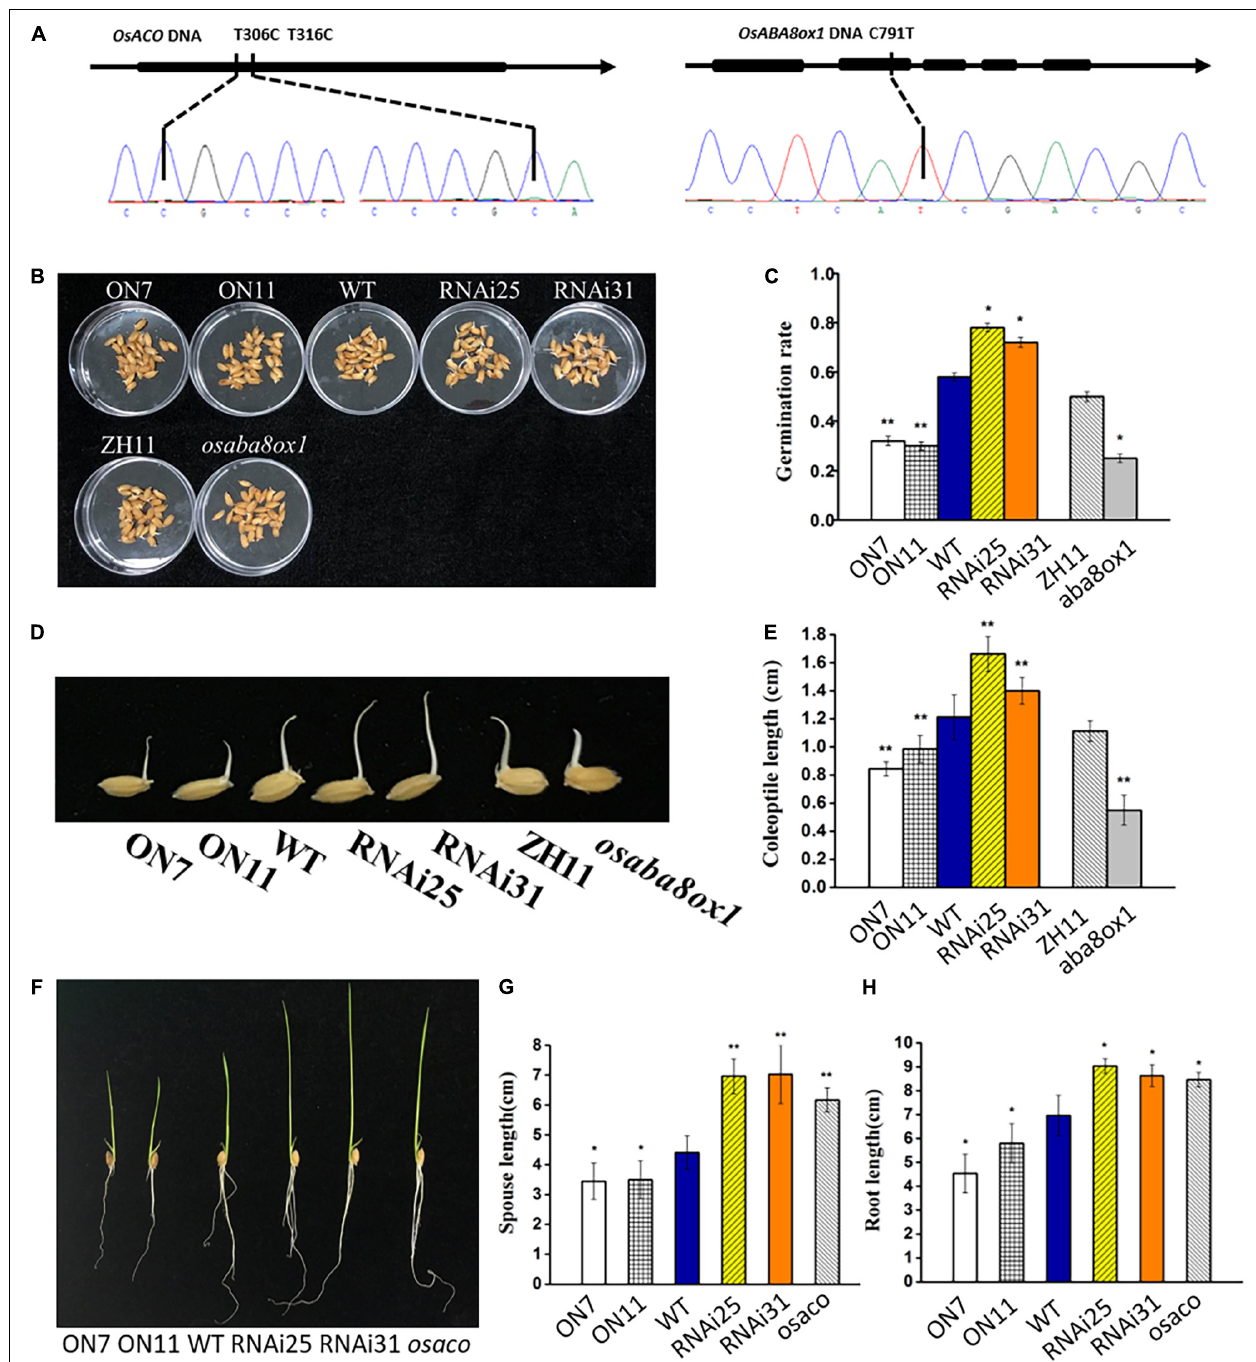
FIGURE 6 | Verification and phenotype and of the osaco and osaba8ox1 lines obtained by using tilling technology. (A) Verification of the osaco and osaba8ox lines by polymerase chain reaction (PCR)-based sequencing. (B) Germination phenotype of the wild-type (WT) and OsNAC2 -transgenic seeds and osaba8ox1 mutant under normal conditions germination. (C) The germination rate of the WT and OsNAC2 -transgenic seeds and osaba8ox1 mutant under normal conditions germination. The experiment was conduct at least three times, with 50 seeds in each Petri dish. (D) Coleoptile phenotype of the WT and OsNAC2 -transgenic seeds and osaba8ox1 mutant under normal conditions germination. (E) Coleoptile length of the WT and OsNAC2 -transgenic seeds and the osaba8ox1 mutant under normal conditions germination. (F) Seedling phenotype of the WT and OsNAC2 -transgenic seedlings and the osaco mutant. (G) Sprout length of the WT and OsNAC2 -transgenic seedlings and the osaco mutant. (H) Root length of the WT and OsNAC2 -transgenic seedlings and the osaco mutant. Error bars represent the standard error of three biological replicates. * p < 0.05, ** p < 0.01, and * p < 0.001.